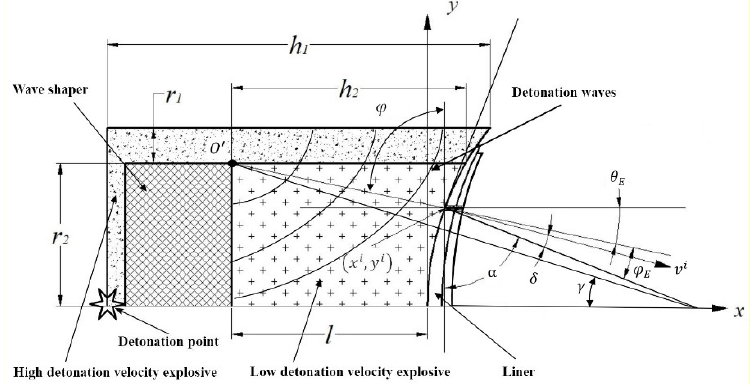
Figure 1. Detonation wave propagation in DLSC.